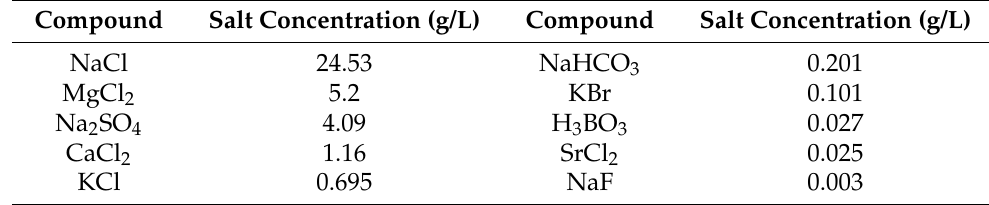
Table 4. Artificial seawater composition according to ASTM D1141-98